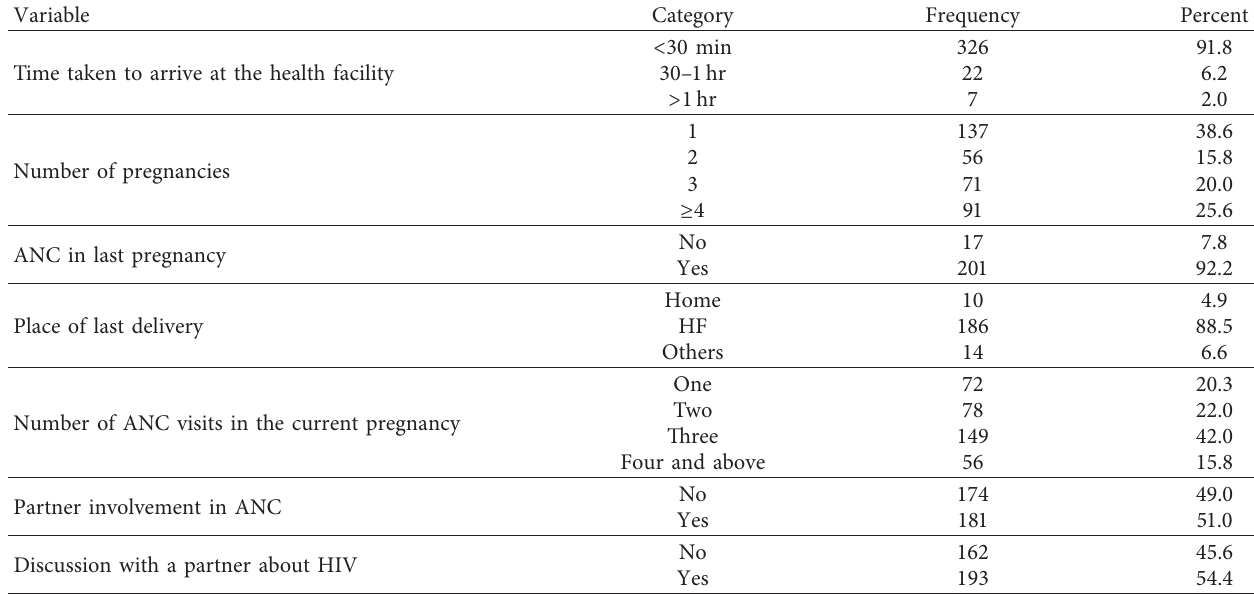
Table 2: Obstetrics and other factors among pregnant women attending ANC at public health facilities, Debre Berhan Town, June 2019 ( N �